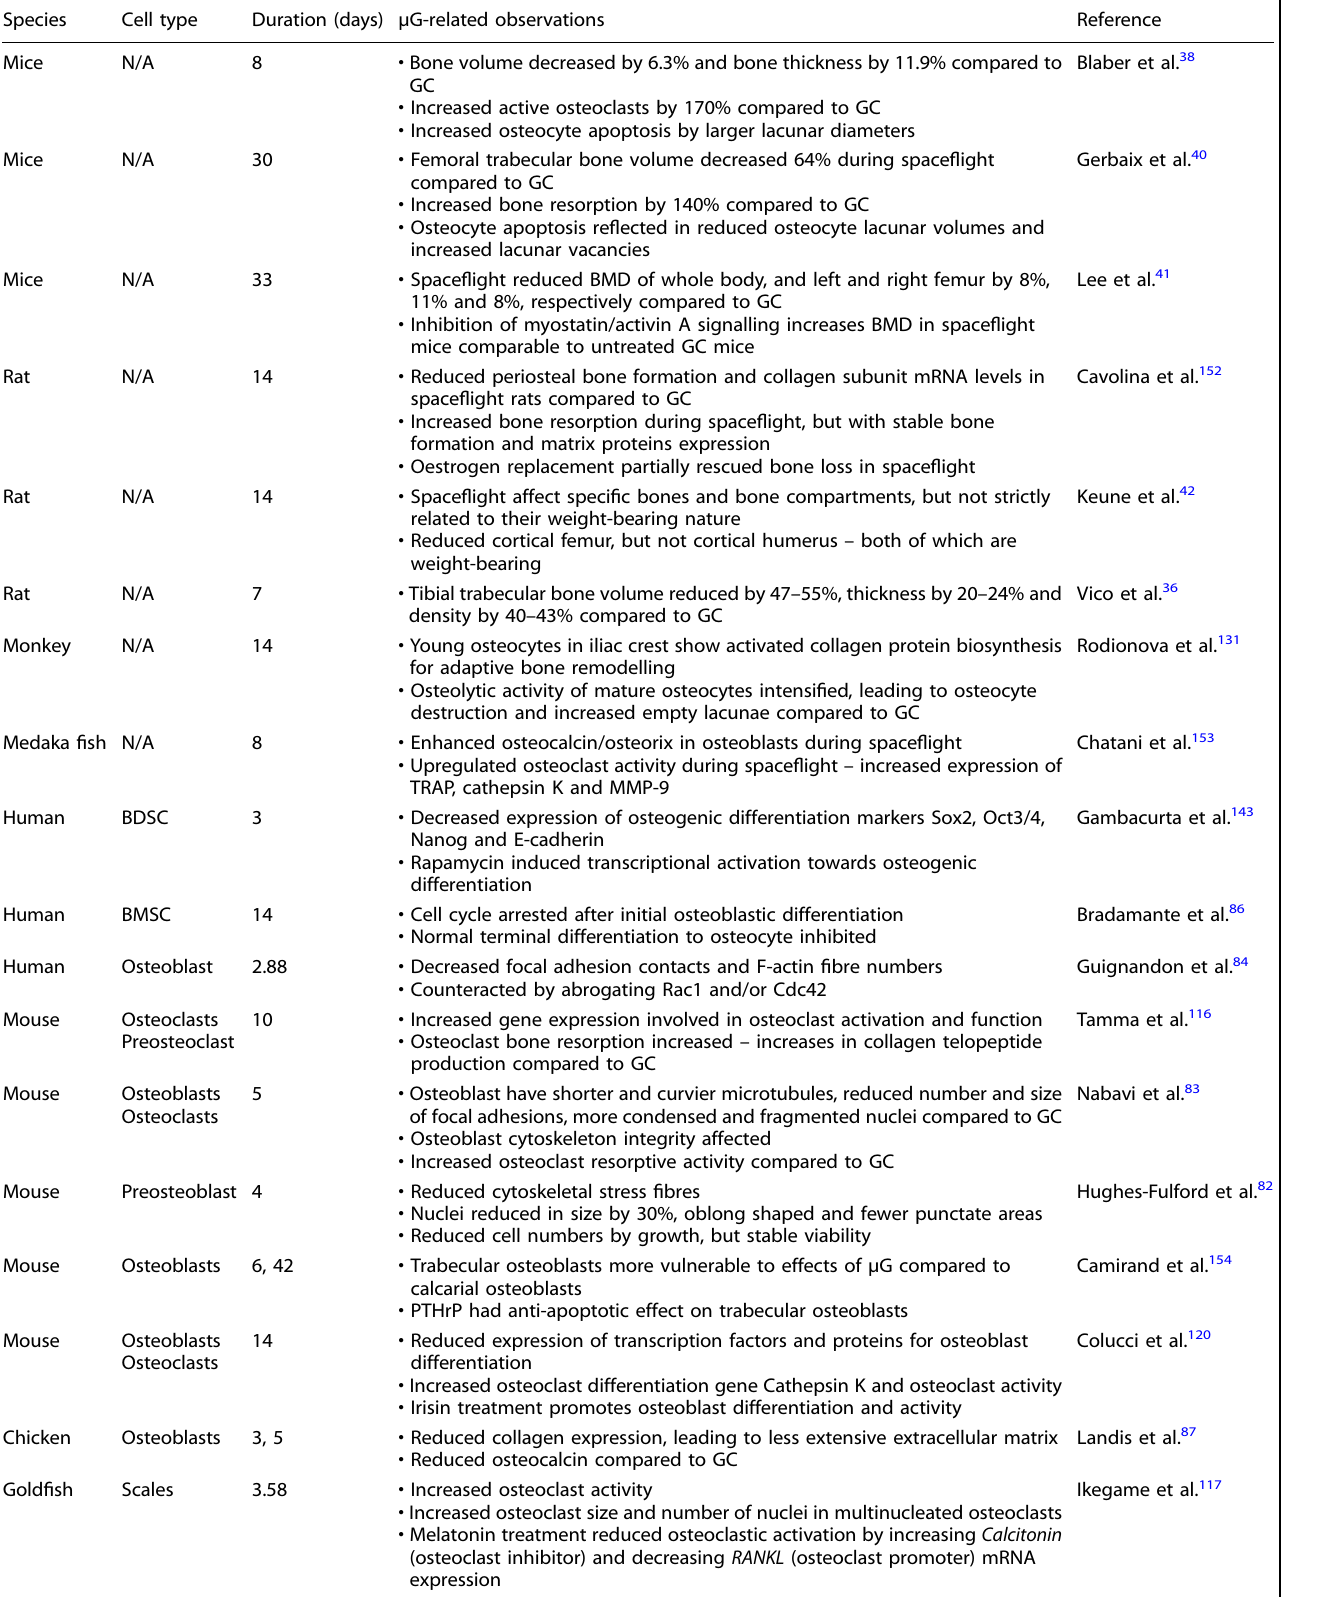
Table 4. Space fl ight studies of animals and bone cells. Species Cell